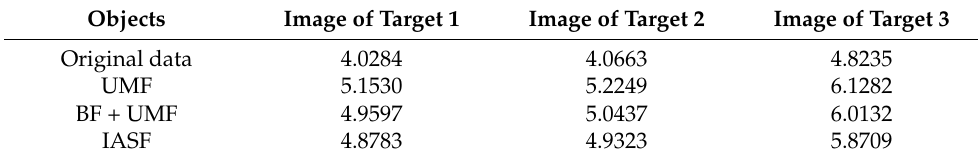
Table 5. The comparison results of entropy for three different images.